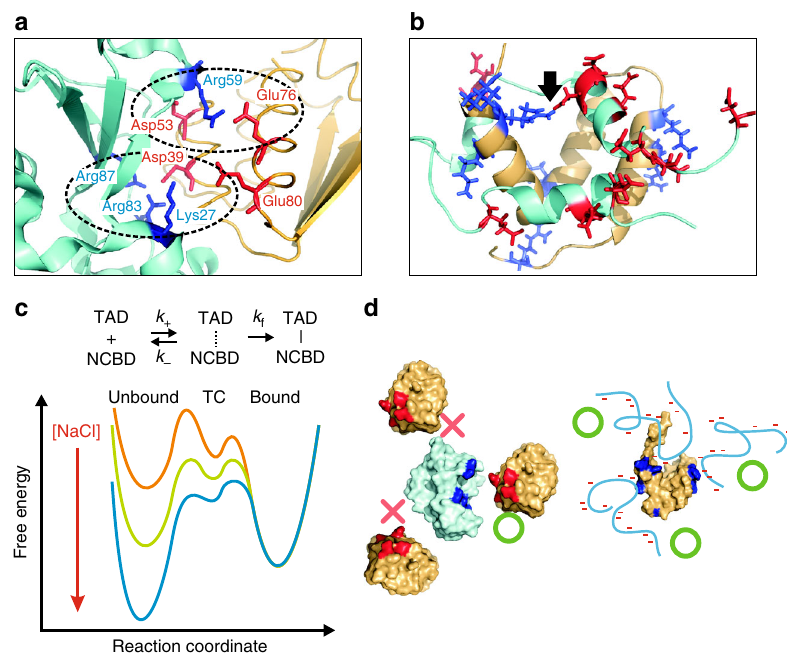
Fig. 4 Binding mechanisms. a Electrostatic interactions in the binding interface of barnase and barstar. Blue and red sticks indicate positively charged side chains of barnase (cyan) and negatively charged side chains of barstar (orange), respectively. Dashed ellipses show two clusters of interacting residues. b Positively charged side chains (blue sticks) of NCBD (orange molecule) and negatively charged side chains (red sticks) of TAD (cyan molecule). Charged side chains are exposed to the solvent and do not interact except those in one salt bridge indicated by a black arrow. Binding interface is predominantly hydrophobic. c Kinetic scheme of the association via the formation of TC, and proposed free energy surface of TAD/NCBD binding with an arbitrary NCBD concentration at different NaCl concentrations. k + and k − are the association and dissociation rate coef fi cients of the formation of TC. k f is the folding rate of unfolded TAD in TC. k A = k + k f /( k f + k − ). As [NaCl] is increased, the formation of TC becomes slower (reduced k + ) due to the increased charge screening effect, and TC becomes less stable and dissociates more easily (increased k − , lowered dissociation barrier) before TAD folds to form a fully bound complex. Both effects decrease k A . d The transition state con fi gurations (indicated by green O) of barnase (cyan) and barstar (orange) are very similar to that of the bound complex, and therefore, the con fi gurations with unfavorable orientations will not result in association (indicated by red x). Positively and negatively charged side chains in the binding interface are colored in blue and red. On the other hand, the association can be initiated from different parts of NCBD (orange) via non-native interactions between charged residues (i.e., parallel binding pathways 23,24 , indicated by green O). Cyan coils represent disordered TAD. Red bars indicate negative charges in TAD and positively charged side chains of NCBD are colored in